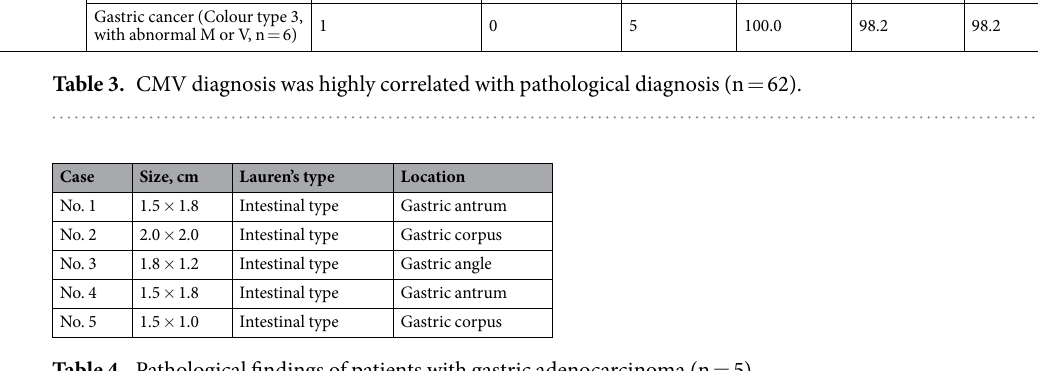
Table 4. Pathological findings of patients with gastric adenocarcinoma (n = 5).